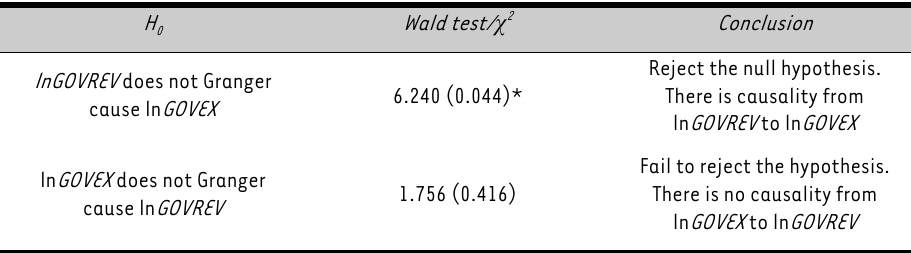
Wald test/ χ 2 Conclusion 6.240 (0.044)*